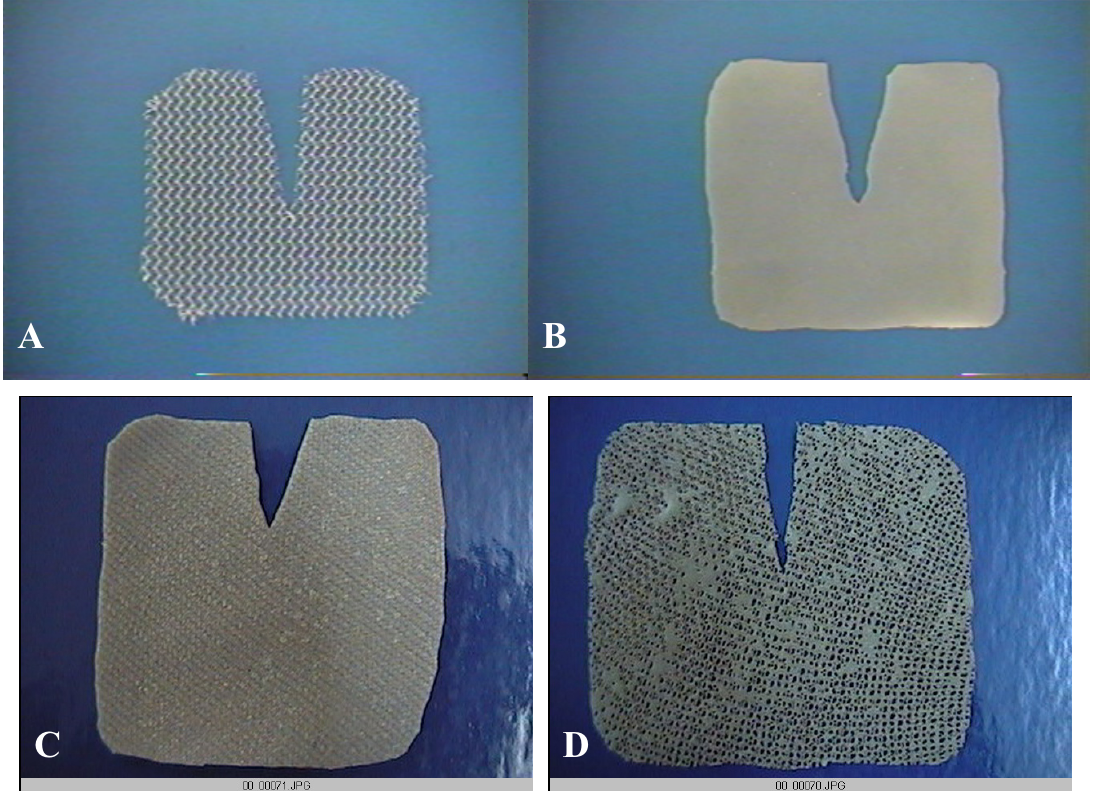
FIGURE 3 – Macroscopic aspect of the prostheses. A – Prolene; B – Impermeable latex biomembrane; C –